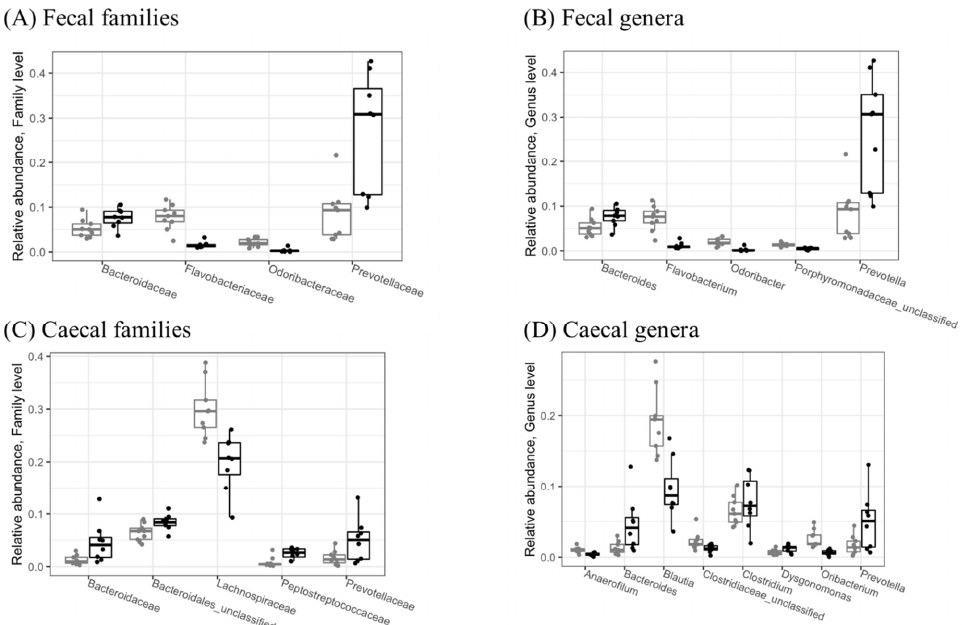
Figure 2. Relative abundances of significantly different ( p < 0.05) microbial families ( A , C ) and genera ( B , D ) in fecal ( A , B ) and cecal ( C , D ) samples collected from the STD (grey) and FG (black) groups of rats ( n = 8–9) at the end of the study (week 23). Only taxa with relative abundance > 1% are shown. Statistical significance was evaluated using the Wald test in DESeq2, version 1.30.1. At the genus level, D ‐ fagomine supplementation significantly ( p < 0.05) increased Bac ‐ teroides and Prevotella while reducing Flavobacterium and Odoribacter in feces (Figure 2B). The increased genera in cecal content were also Bacteroides and Prevotella , together with Clostridium and Dysgonomonas (Figure 2D), while the genera Anaerofilum , Blautia and Ori ‐ bacterium were significantly reduced by D ‐ fagomine intake.